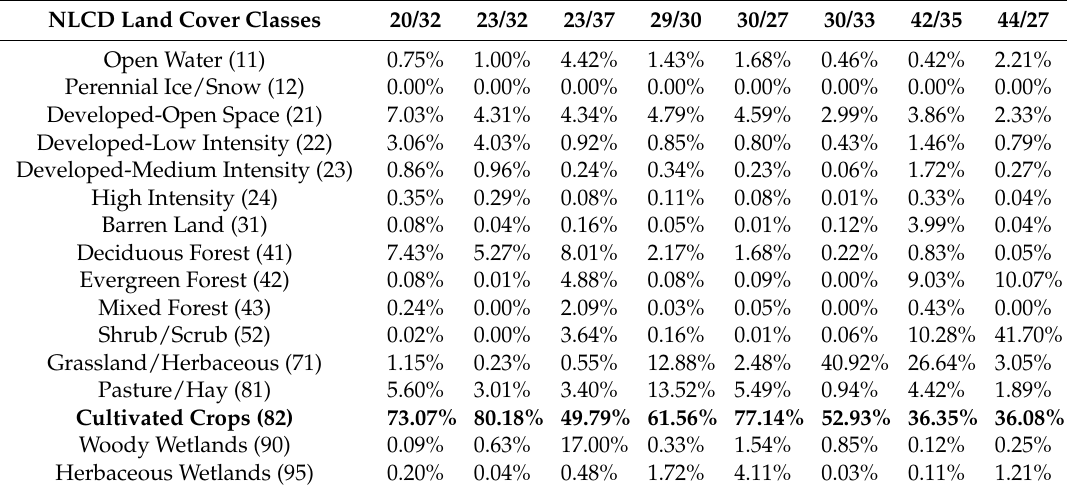
Figure 1. National Land Cover Database (NLCD) area with specific Landsat path/row study areas in blue. Table 1. NLCD 2006 land cover percentages by path/row.